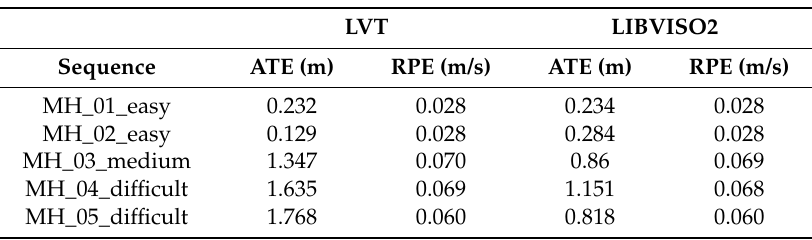
Table 4. RMSE values of absolute trajectory error (ATE) and relative pose error (RPE) on EuRoC datasets.